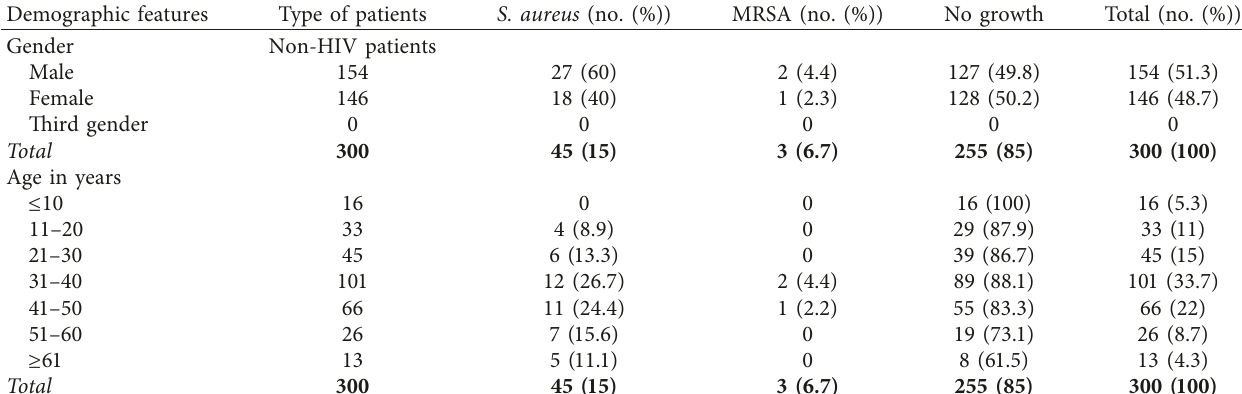
Table 2: Socio demographic characteristics of the non-HIV patients and ratio of S. aureus carriage. Demographic features